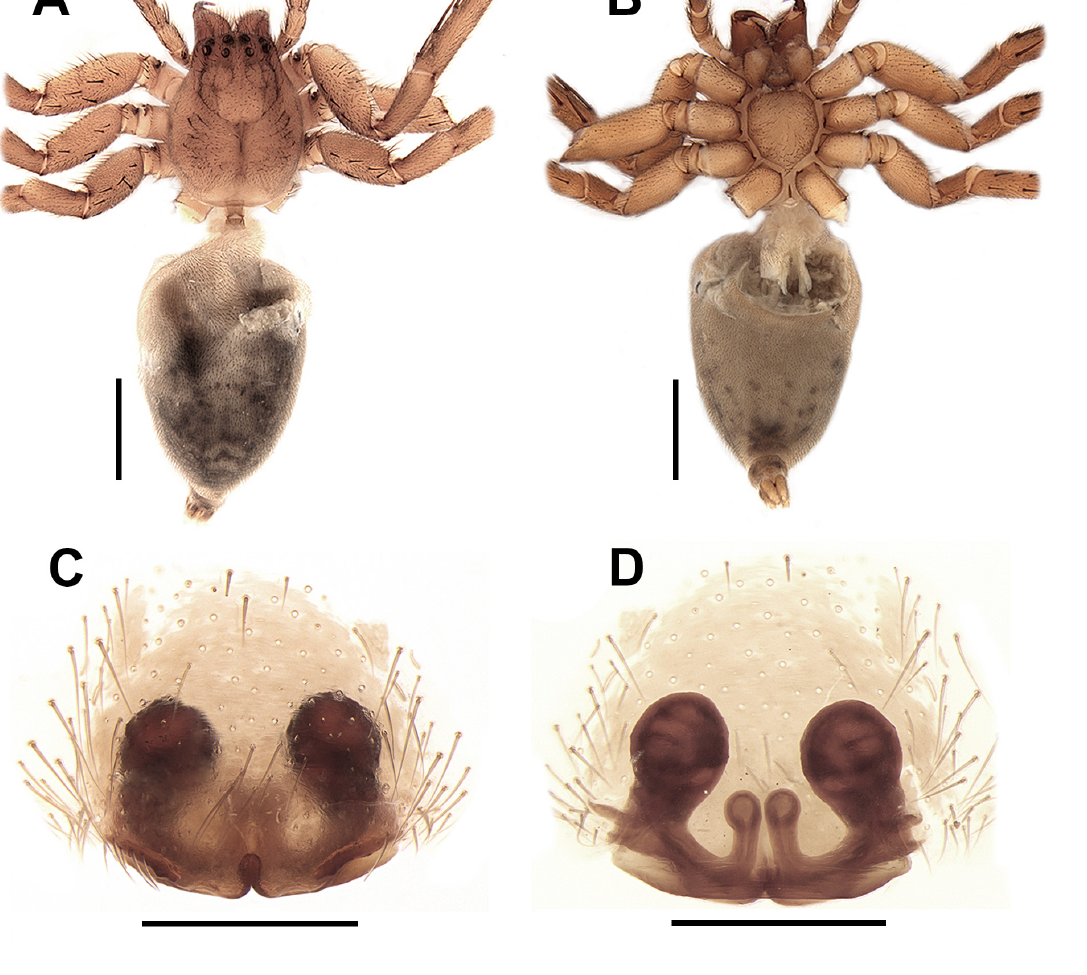
Fig. 4. Cuiambuca aratangi sp. nov., paratype, ♀ (IBSP 8907). A . Habitus, dorsal view. B . Habitus, ventral view. C . Epigyne, ventral view. D . Vulva, dorsal view. Scale bars = 0.5